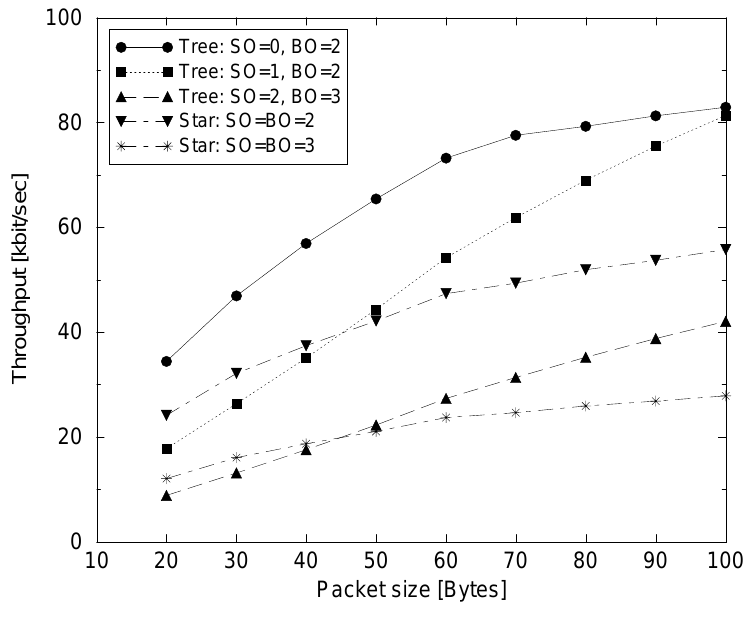
Figure 12. Throughput as a function of packet size for an 802.15.4 network organised in star and tree-based